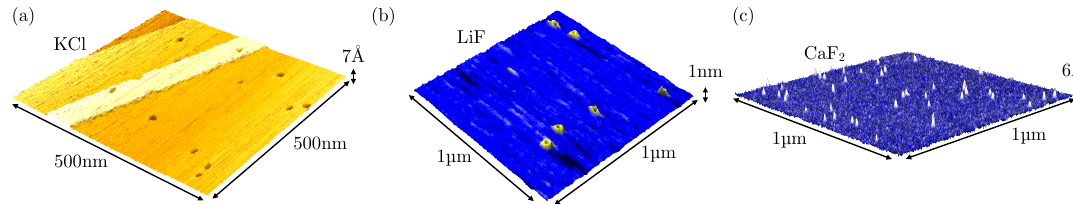
Figure 3. (Color online) ( a ) Atomic force microscopy image of a KCl(001) surface irradiated with 70 keV Xe 35 + ions. One- to two-monolayer-deep pits resulting from single ion impacts can be observed [33,39]. ( b ) AFM image of a LiF(001) surface irradiated with 99 keV Xe 20 + ions. Crater-like structures are observable [36]. ( c ) AFM image of a CaF 2 (111) surface irradiated with 16.5 keV Xe 33 + ions. Hillock structures can be observed